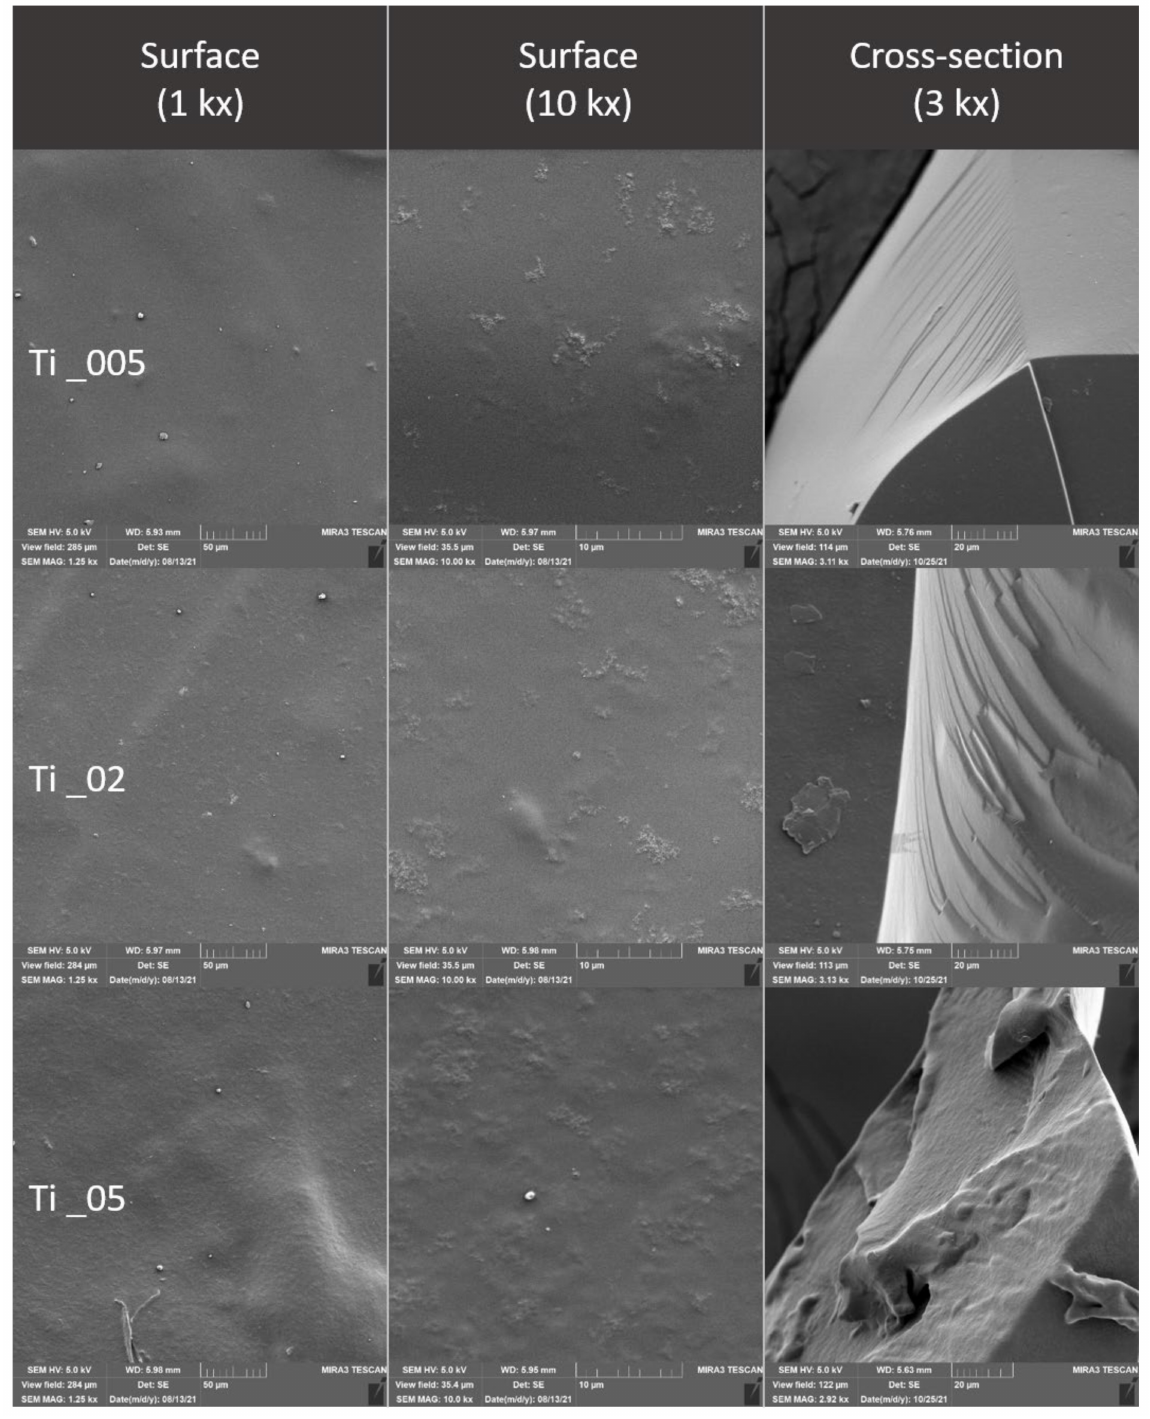
Figure 11. Surface and fracture microstructure of edible packaging with the addition of TiO 2